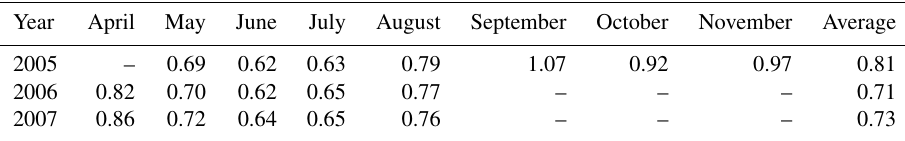
Table 2. CC-derived average values of K d for each month (2005–2007). The values correspond to the time of year when water LSWT observations, as well as the CC derived K d values, are available.